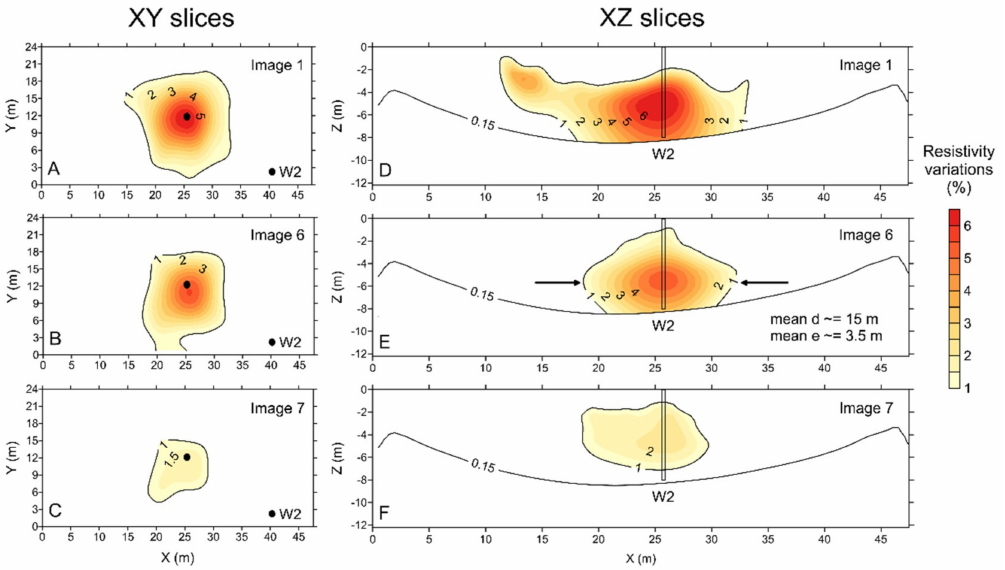
Figure 11. XY slices (Z = -6.2 m) (left) and XZ slices (Y = 12 m) of changes in bulk electrical resistivity for di ff erent timesteps (images 1, 6, and 7, respectively in A , B , and C and in D , E , and F ) with all the filters